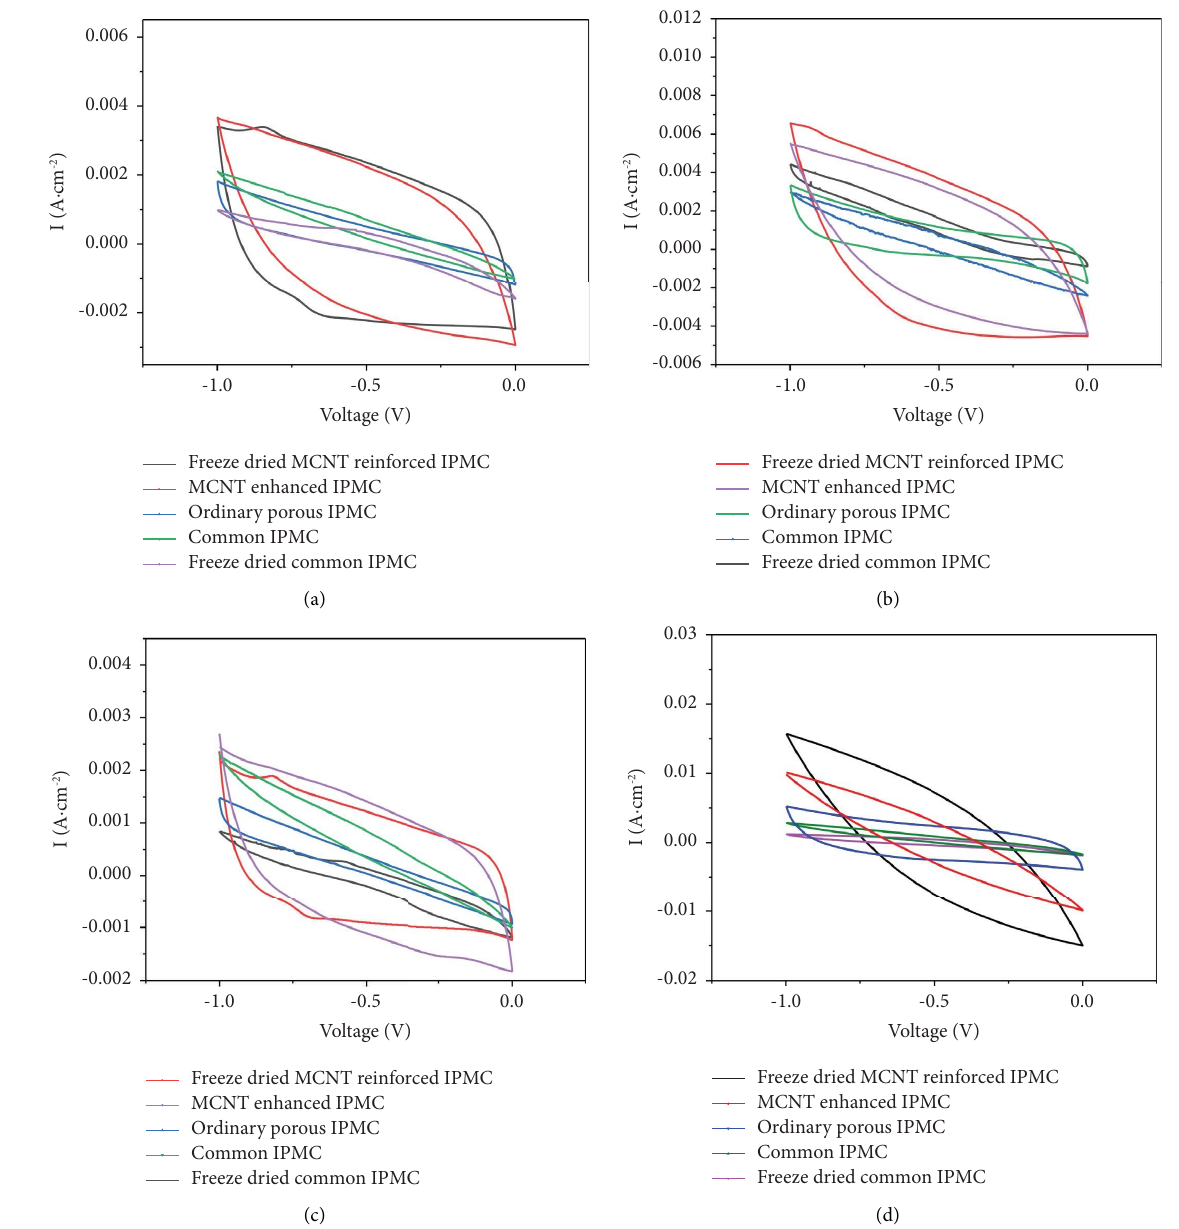
Figure 4: CV diagram with scanning interval of − 1v-0 v and diferent scanning speeds: (a) 50mV/s; (b) 100mV/s; (c) 200mV/s; (d)